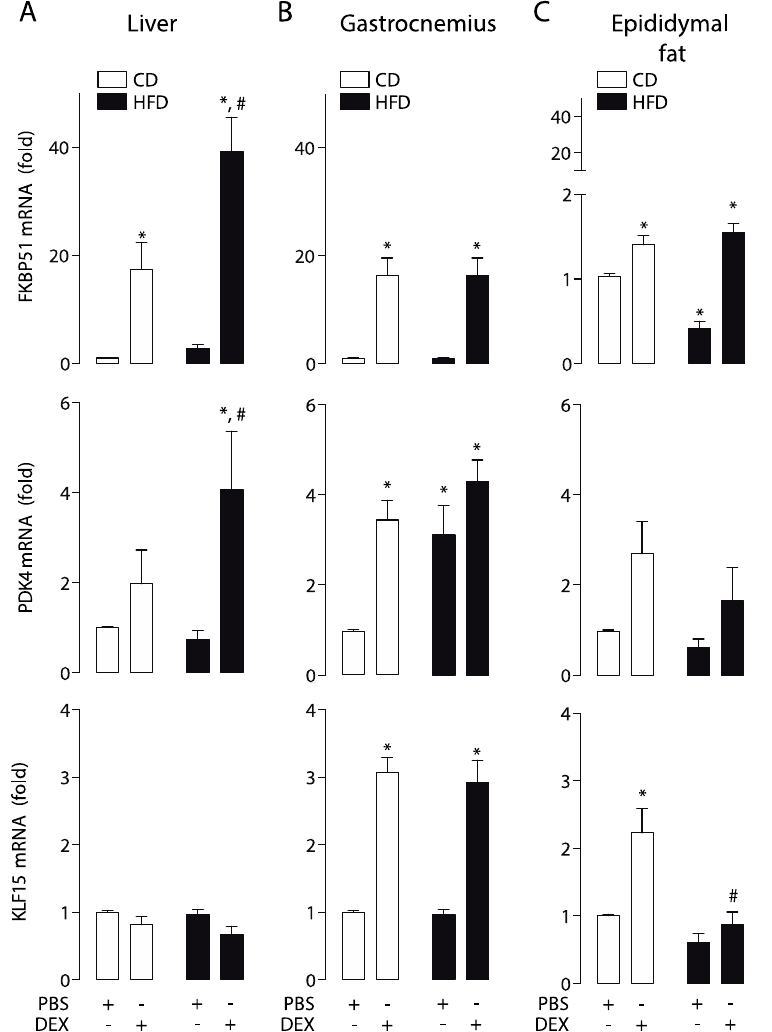
Figure 2. A high-fat diet alters the glucocorticoid receptor (GR) response in a tissue-specific manner. FK506-binding protein 51 (FKBP51), pyruvate dehydrogenase kinase 4 (PDK4), and Krüppel-like factor 15 (KLF15) mRNA levels were determined by qPCR in the liver, gastrocnemius, and epididymal fat obtained from high-fat diet (HFD) or control diet (CD) mice treated with a dexamethasone injection (DEX; 2 mg/Kg i.p.) or phosphate-buffered saline (PBS). ( A ) mRNA expression in the liver. ( B ) mRNA expression in the gastrocnemius. ( C ) mRNA expression in epididymal fat. n = 6 mice per condition. Two-way analysis of variance (ANOVA) was conducted, followed by Tukey’s post hoc test. * p < 0.05 vs. CD + PBS, # p < 0.05 vs. CD + DEX. Values are expressed as mean ± standard error of mean.